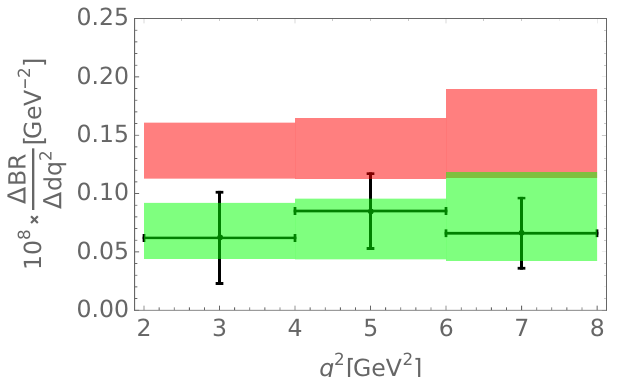
Figure 2 . Theoretical predictions for di(cid:11)erential branching fraction of the B (cid:6) ! (cid:25) (cid:6) (cid:22) + (cid:22) (cid:0) decays in comparison with the data (black) by the LHCb collaboration [44]. The red bands correspond to the SM prediction [49] and green ones indicate the NP result (for the solution in eq.